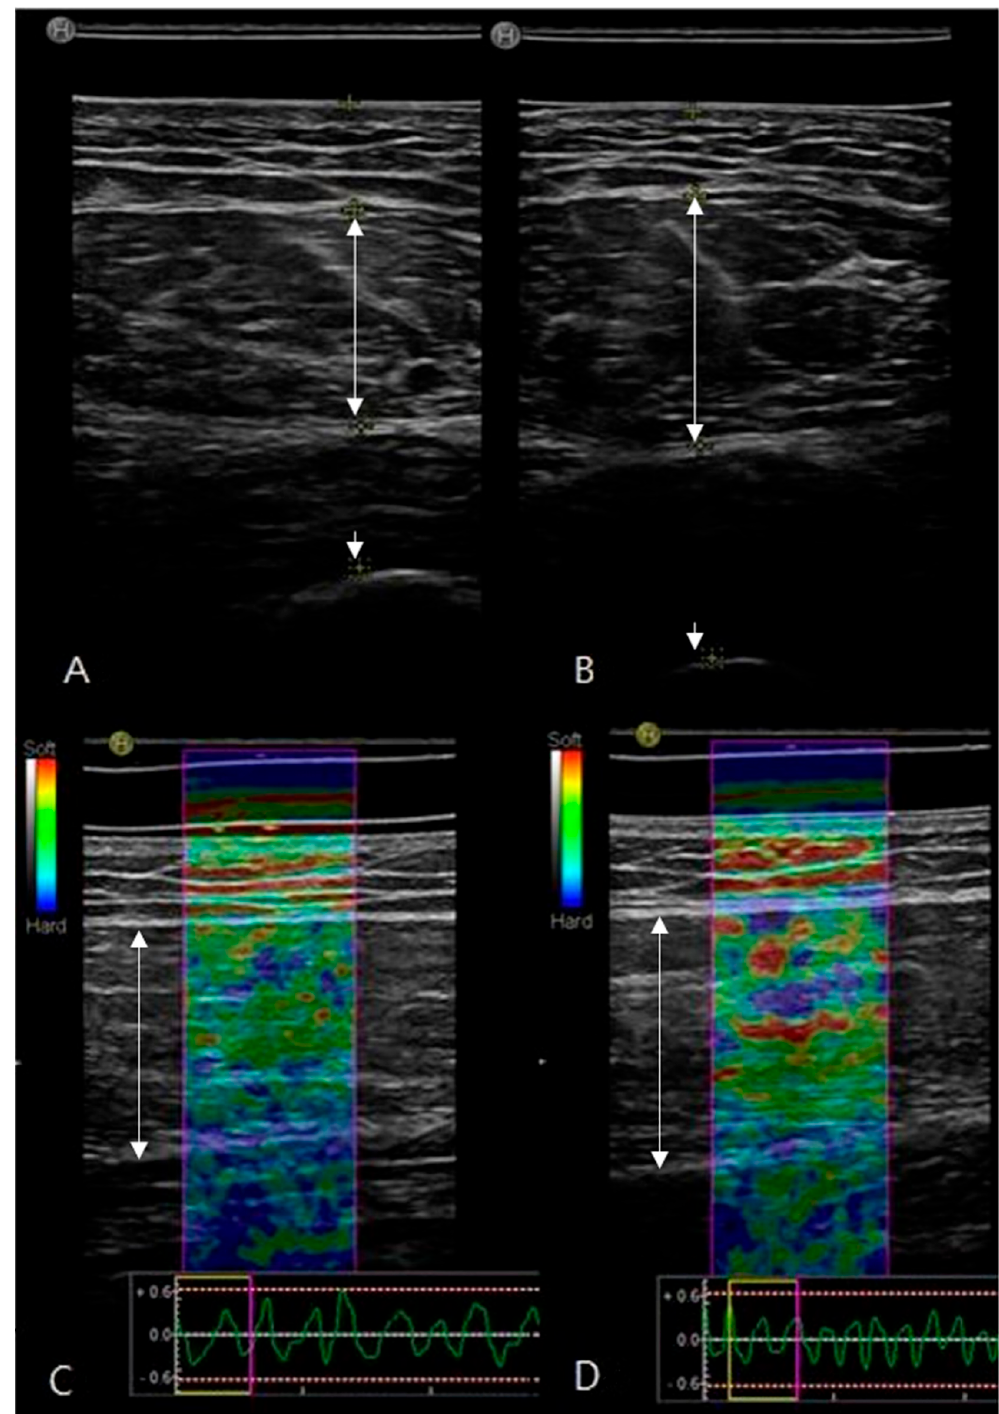
Figure 1. This is an example of an ultrasound of rectus femoris. The single arrow is the cortex of the femur and the double arrow is the rectus femoris. ( A , C ) B-mode transverse scan for the thickness of the rectus femoris (paretic 14.51 ± 2.47, non-paretic 15.31 ± 2.49), echo intensity measurements (paretic 43.94 ± 15.58, non-paretic 40.35 ± 14.45), and real-time strain elastography longitudinal scan with a pressure wave for strain ratio of elastography (paretic 1.86 ± 1.06, non-paretic 1.68 ± 0.77) showed in the sarcopenia group. ( B , D ) B-mode for the thickness of the rectus femoris (paretic 17.32 ± 3.83, non-paretic 18.50 ± 3.66), echo intensity measurements (paretic 35.75 ± 11.59, non-paretic 34.51 ± 15.52), and real-time strain elastography with a pressure wave for strain ratio of elastography (paretic 1.41 ± 0.63, non-paretic 1.36 ± 0.53) showed in the non-sarcopenia group.